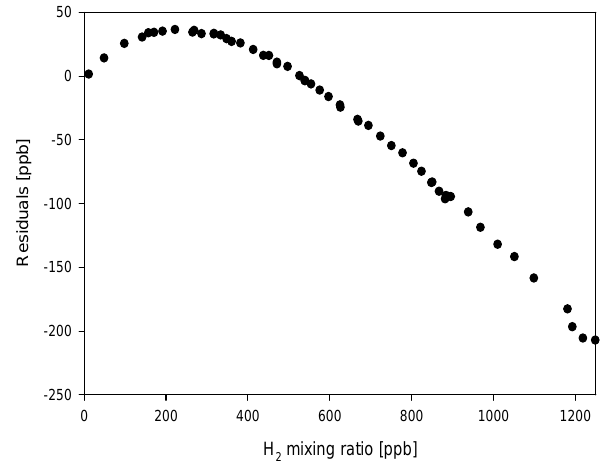
Figure 7. Residuals of a linear regression fit of the GC-HgO detector signals for the set of 53 2 Fig. 7. Residuals of a linear regression fit of the GC-HgO detector H 2 -in-air mixtures. Displayed is the difference: (H 2 amount mixed) - (measured H 2 mixing 3 signals for the set of 53H 2 -in-air mixtures. Displayed is the differ- ratio) based on a one point calibration 4 ence: (H 2 amount mixed)–(measured H 2 mixing ratio) based on a one point